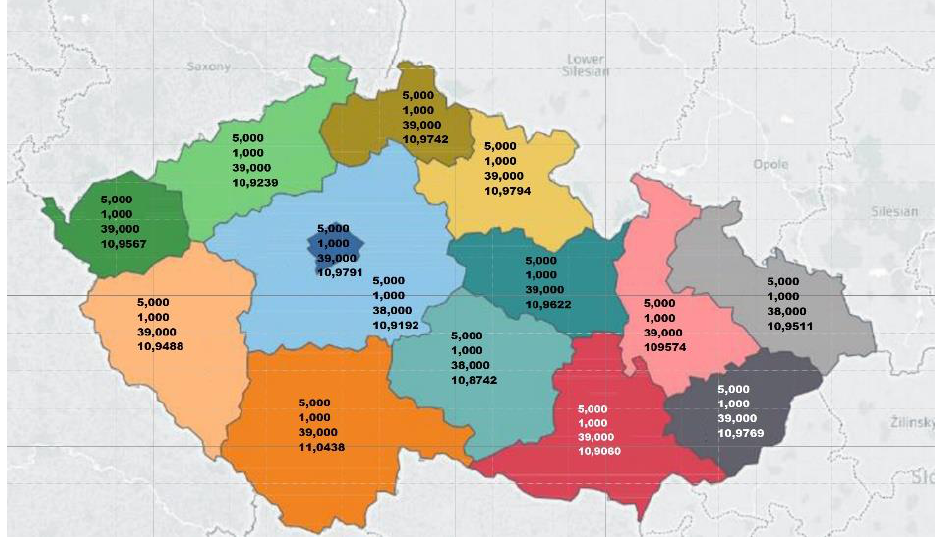
Figure 5. Example of under-10 s real-life diagnosis as regional data visualisation in the Czech Republic using Tableau Desktop (version 10.5). In addition to data integration, geo-mapping functionality provides near real-time pandemic / epidemic mapping, tracking, outbreak spread, and risk data